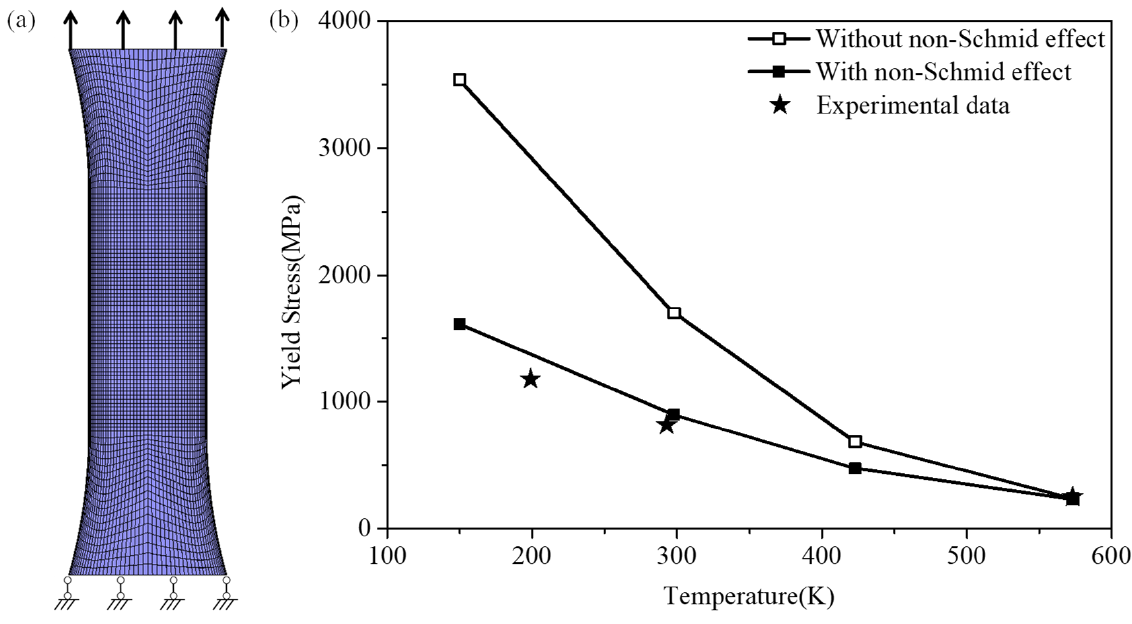
Figure 1. The NS effect on the yield stress of tungsten at different temperatures. ( a ) Boundary condition of the cylindrical dog-bone shaped specimen. ( b ) Predicted yield stress under the two conditions and the experimental data from [45,46].